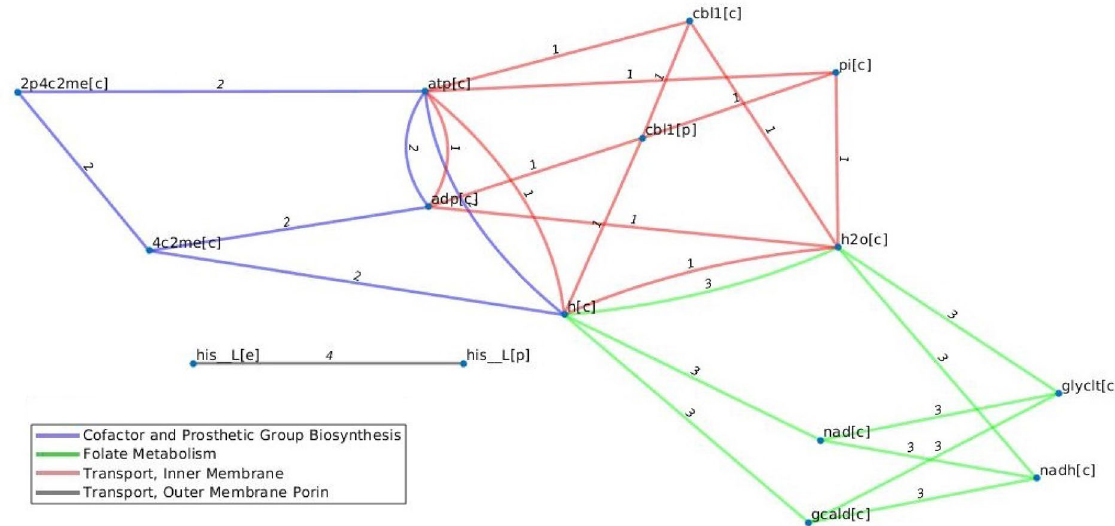
Figure 6. Trade-offs with four reactions in the model of E. coli under different carbon sources. The trade-offs with four reactions with thymidine are also present in the trade-offs with L-Arabinose as a carbon source. The following reactions are included (1) 4-(cytidine 5’-diphospho)-2-C-methyl-D-erythritol kinase, (2) Cob(1) alamin transport via ABC system (periplasm), (3) Glycolaldehyde dehydrogenase, and (4) L-histidine transport via diffusion (extracellular to periplasm). Nodes correspond to the following metabolites, Adp: ADP, 4c2me: 4-(cytidine 5’-diphospho)-2-C-methyl-D-erythritol, 2p4c2me: 2-phospho-4-(cytidine 5’-diphospho)-2-C- methyl-D-erythritol, atp: ATP, cbl1:Cob(I)alamin, gcald: Glycolaldehyde, glyclt: Glycolate, h:H + , h2o: water, nad: Nicotinamide adenine dinucleotide, nadh: Nicotinamide adenine dinucleotide-reduced, pi :Phosphate, his_L: L-Histidine. [c] corresponds to cytoplasm, and [p] corresponds to periplasm.